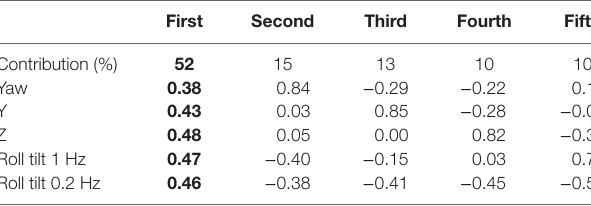
TaBle 4 | Principal component analysis of age-adjusted, log-transformed thresholds for all subjects.